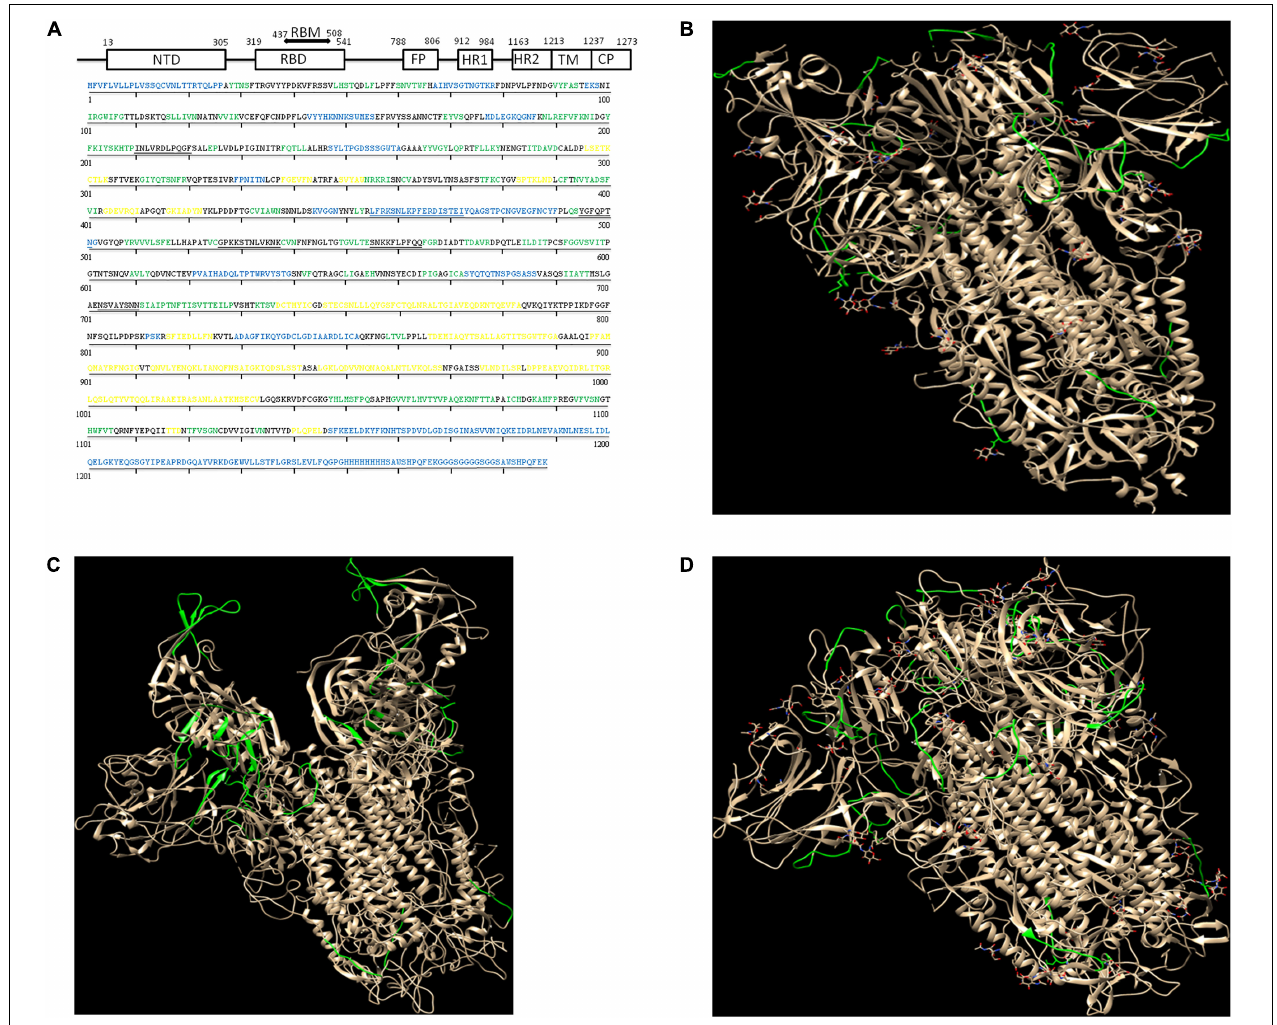
FIGURE 1 | Location of the proposed regions in the Spike protein and comparison with Spike proteins from other coronavirus. (A) Top: schematic view of the Spike protein with the specifications of the different domains: NTD, N-Terminal Domain; RBD, Receptor Binding Domain; RBM, Receptor Binding Motif; FP, Fusion Peptide; HR1, Heptad Repeat 1; HR2, Heptad Repeat 2; TM, TransMembrane region; CP, Cytoplasmic Domain. The S1 domain consists of the NTD and RBD regions. Bottom: primary sequence of Spike protein in SARS-CoV-2 in the prefusion state (Wrapp et al., 2020; PDB code 6vsb, chain A). Helices are colored in yellow, sheets are colored in green and the missing regions in the crystal structure are colored in blue. The regions reported in the text are underlined. (B) 3D structure of Spike protein in SARS-CoV-2 in the prefusion state (Wrapp et al., 2020; PDB code 6vsb) where the regions reported in the text are colored in green for each monomer. (C) 3D structure of Spike protein in MERS-CoV in the prefusion state (Yuan et al., 2017; PDB code 5 × 5c). The regions corresponding to the ones reported in text are colored in green for each monomer. (D) 3D structure of Spike protein in SARS-CoV in the prefusion state (Yuan et al., 2017; PDB code 5 × 58). The regions corresponding to the ones reported in text are colored in green for each monomer. The equivalent residues in MERS-CoV and SARS-CoV were obtained by multiple alignment using the ClustalW software (Larkin et al., 2007). The figures were prepared with Chimera software (Pettersen et al.,